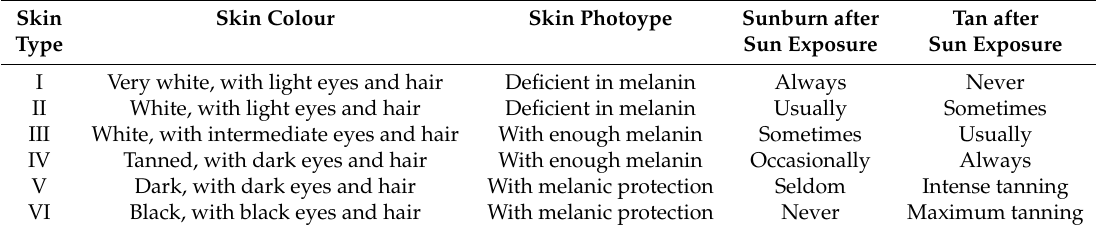
Table 1. Skin types defined by Fitzpatrick and its characteristics